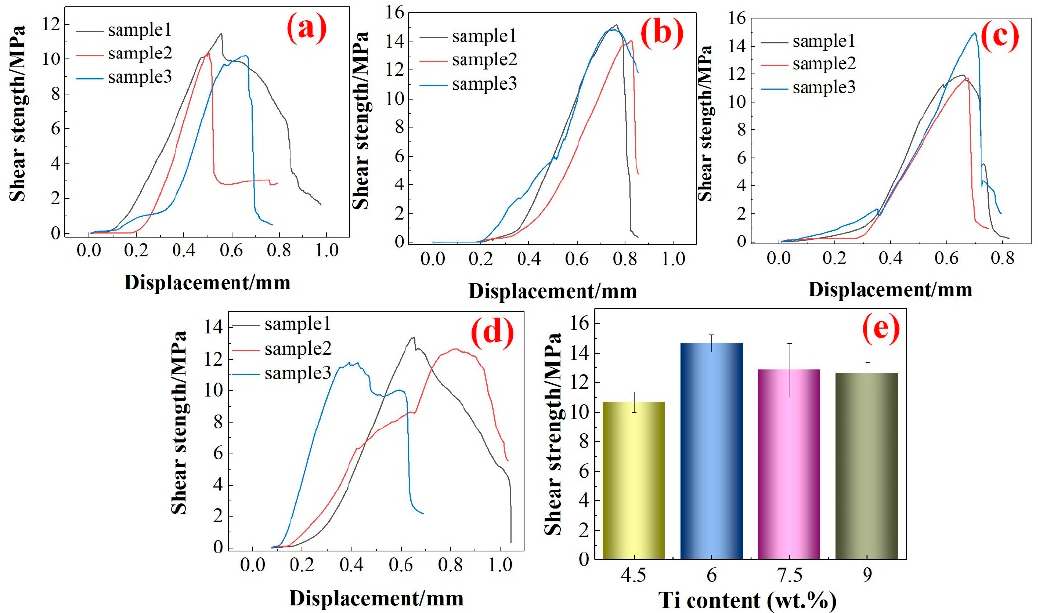
Figure 6. Schematic diagram of shear strength with different Ti contents: The strength-displacement curves of the welded joints with ( a ) 4.5 wt.% Ti, ( b ) 6 wt.% Ti, ( c ) 7.5 wt.% Ti, ( d ) 9 wt.% Ti, and ( e ) the comparison results of the average strength.